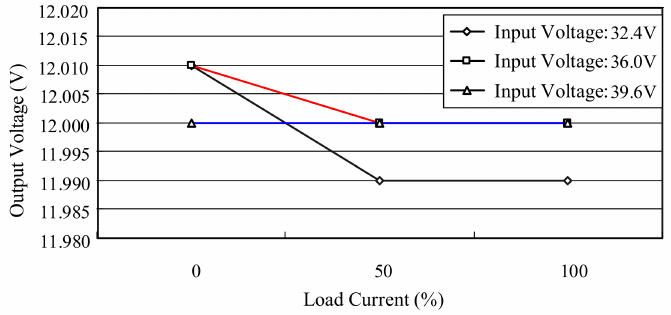
Figure 29. Curve of main output voltage versus load current on condition that the first and second secondary outputs are located at rated load.